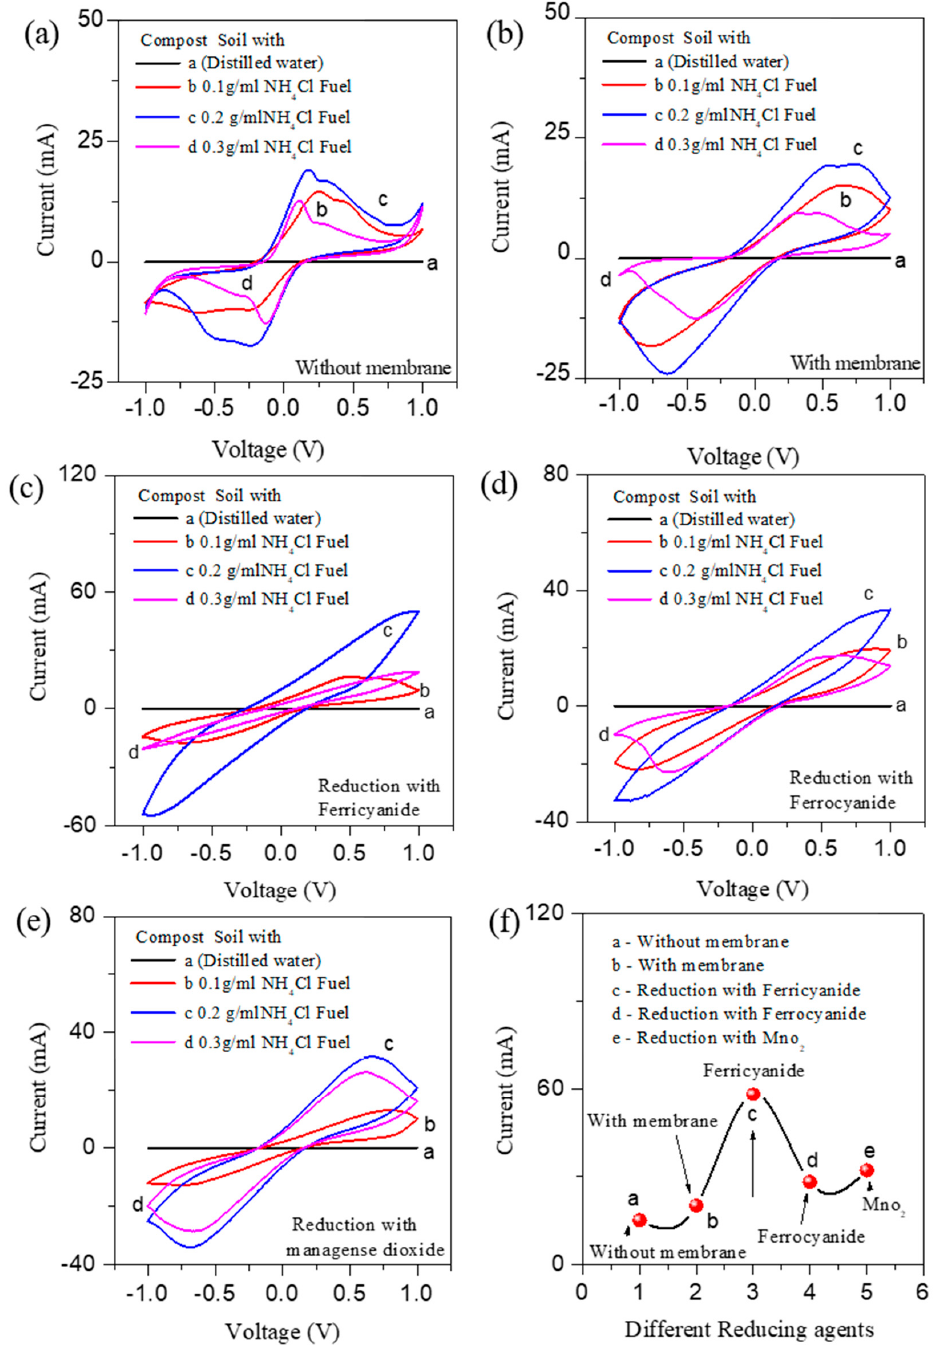
Figure 1. Bipolar C-V studies showing the comparison of varying fuel concentrations in CS-AFCs using reductions: ( a ) without membrane, ( b ) with membrane, ( c ) ferricyanide, ( d ) ferrocyanide, and ( e ) manganese dioxide; ( f ) comparison of the redox potential performance with different reducing agents.